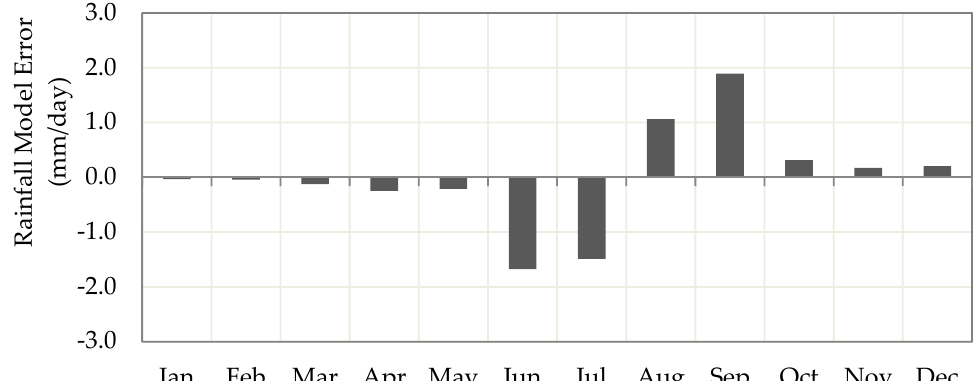
Figure 4. Model error of rainfall between observed and downscaled data of the baseline period (1961–1990).